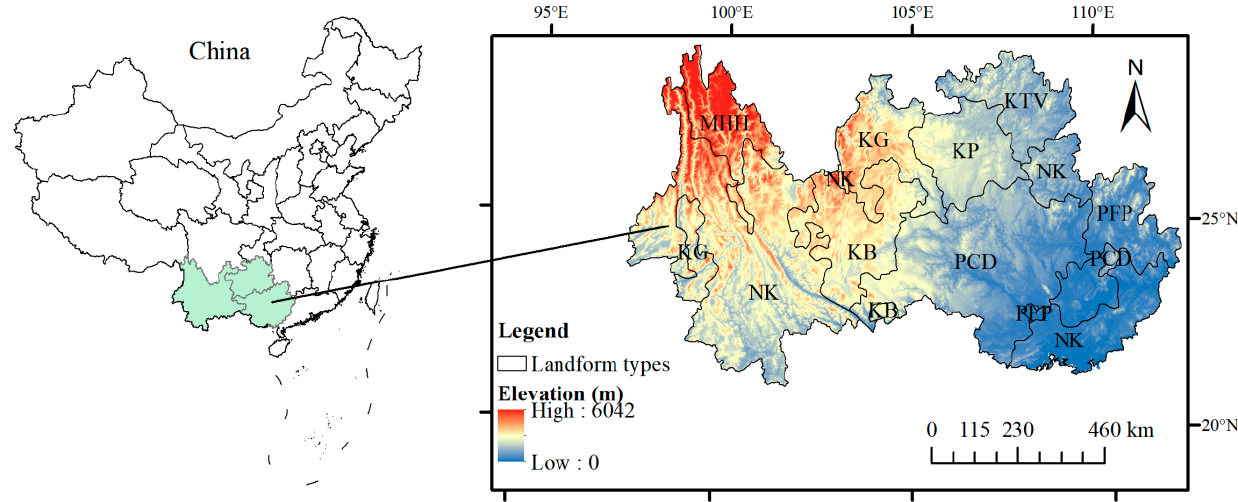
Figure 1. The location and elevation in the karst areas of Southwest China (the administrative map was obtained from the National Earth System Science Data Center (http://www.geodata.cn/, accessed on 15 August 2018)). The elevation data were obtained from Geospatial Data Cloud (http://www.gscloud.cn/search, accessed on 9 March 2021). The landform type data were obtained from the previous study by Wang et al. [32]) (PFP: peak forest plain; KG: karst gorge; NK: non-karst region; KB: karst basin; MHB: middle-high hill; PCD: peak cluster depression; KTV: karst trough valley; KP: karst plateau).